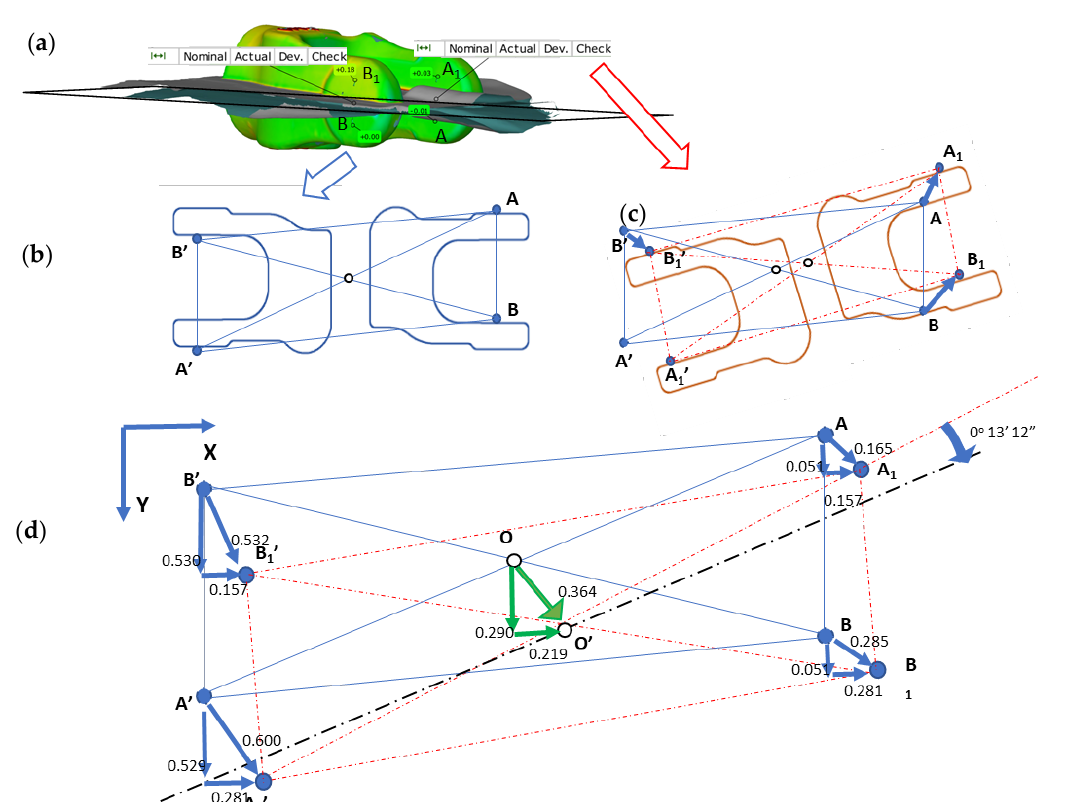
Figure 18. ( a ) The results of the analysis of the joggle defect for a single yoke, a diagram of a forging from a two-component system: ( b ) lower half of the die with the nominal position of the points, ( c ) lower half of the die with resultant joggle vectors, ( d ) diagram of dimensional compensation with calculated values of mean joggle necessary to determine the corrections.